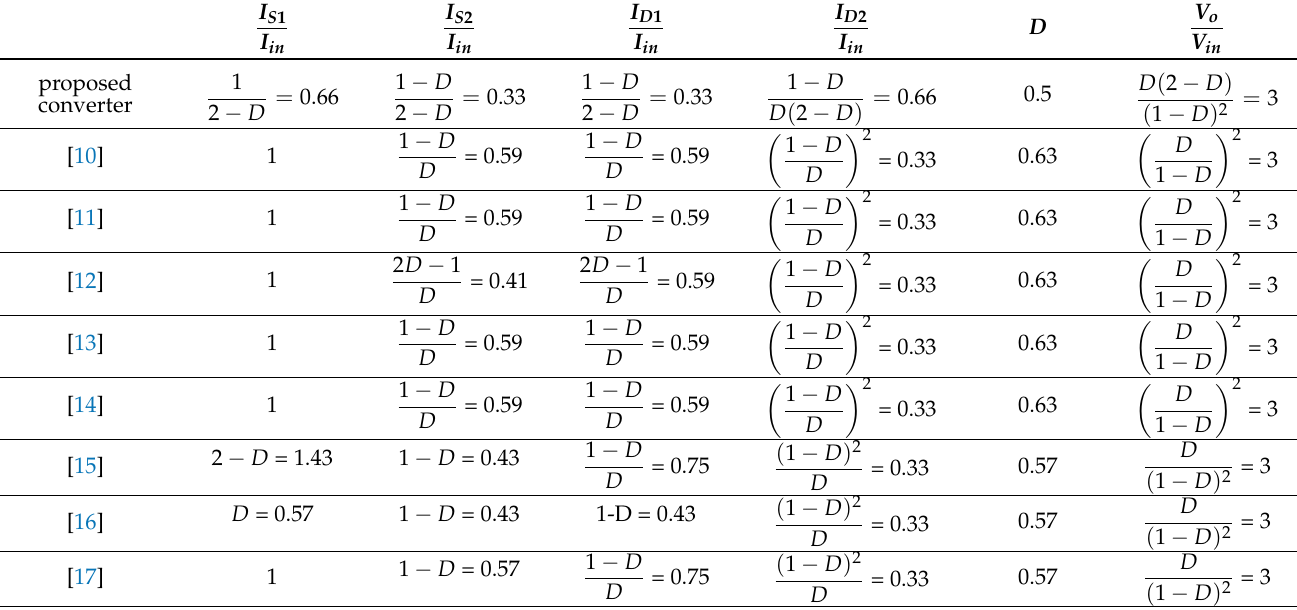
Table 4. Comparison of the normalized current stress of semiconductors as the voltage gain ratio equals 3.